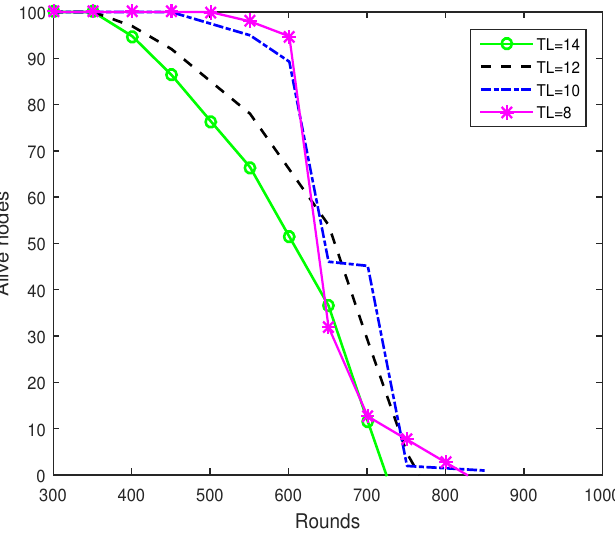
Figure 6. Network lifetime of proposed mechanism with different energy Total Level (TL).